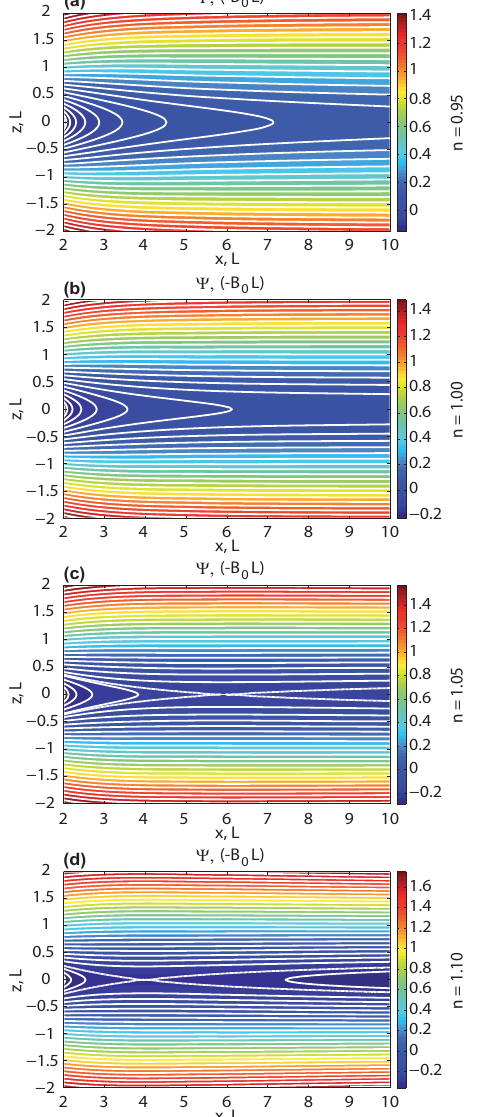
Figure 6. The values of magnetic potential (cid:57)(x,z) , calculated from analytical model (Eqs. 11–16), are shown by color for model parameter n = { 0 . 95 , 1 , 1 . 05 , 1 . 1 } on panels (a) – (d) , respec- tively. Other parameters { a = 0 , b 0 = 1 , ϕ = 0 , f = 0 , k = 1 } are the same. Magnetic field lines are plotted by white curves. Panel (b) shows the original Kan solution.